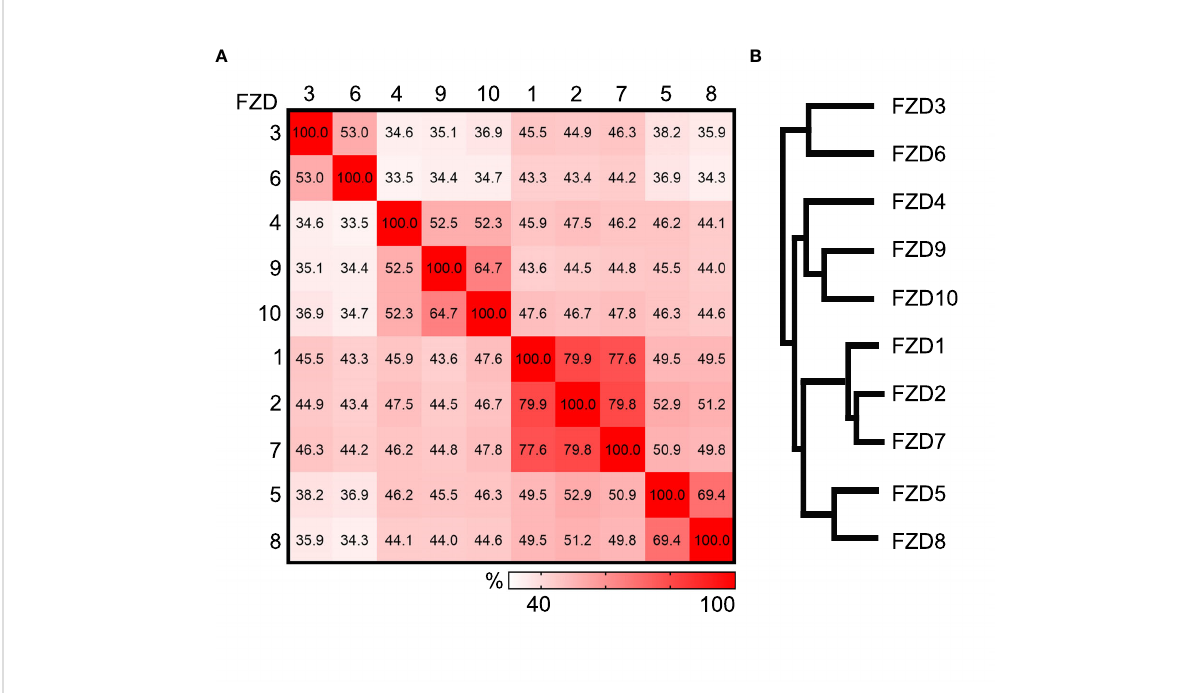
FIGURE 1 Comparison of human Frizzled proteins. (A) Heat plot showing the percent identity matrix of the 10 human Frizzled amino acid sequences. (B) Phylogram showing the relatedness of the 10 human FZDs. Sequence compared using the Clustal Omega multiple sequence alignment